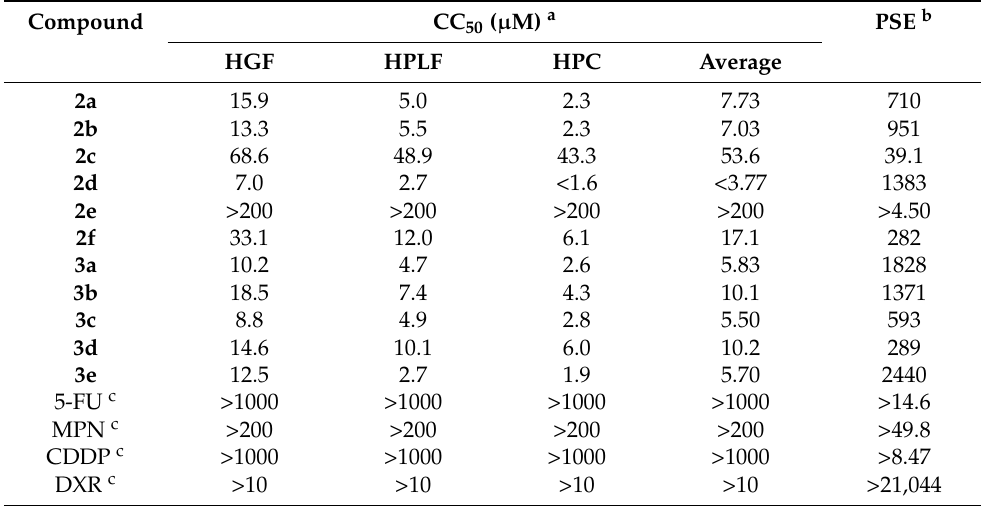
Table 3. Evaluation of 2a – f and 3a – e against three non-malignant oral cell lines.